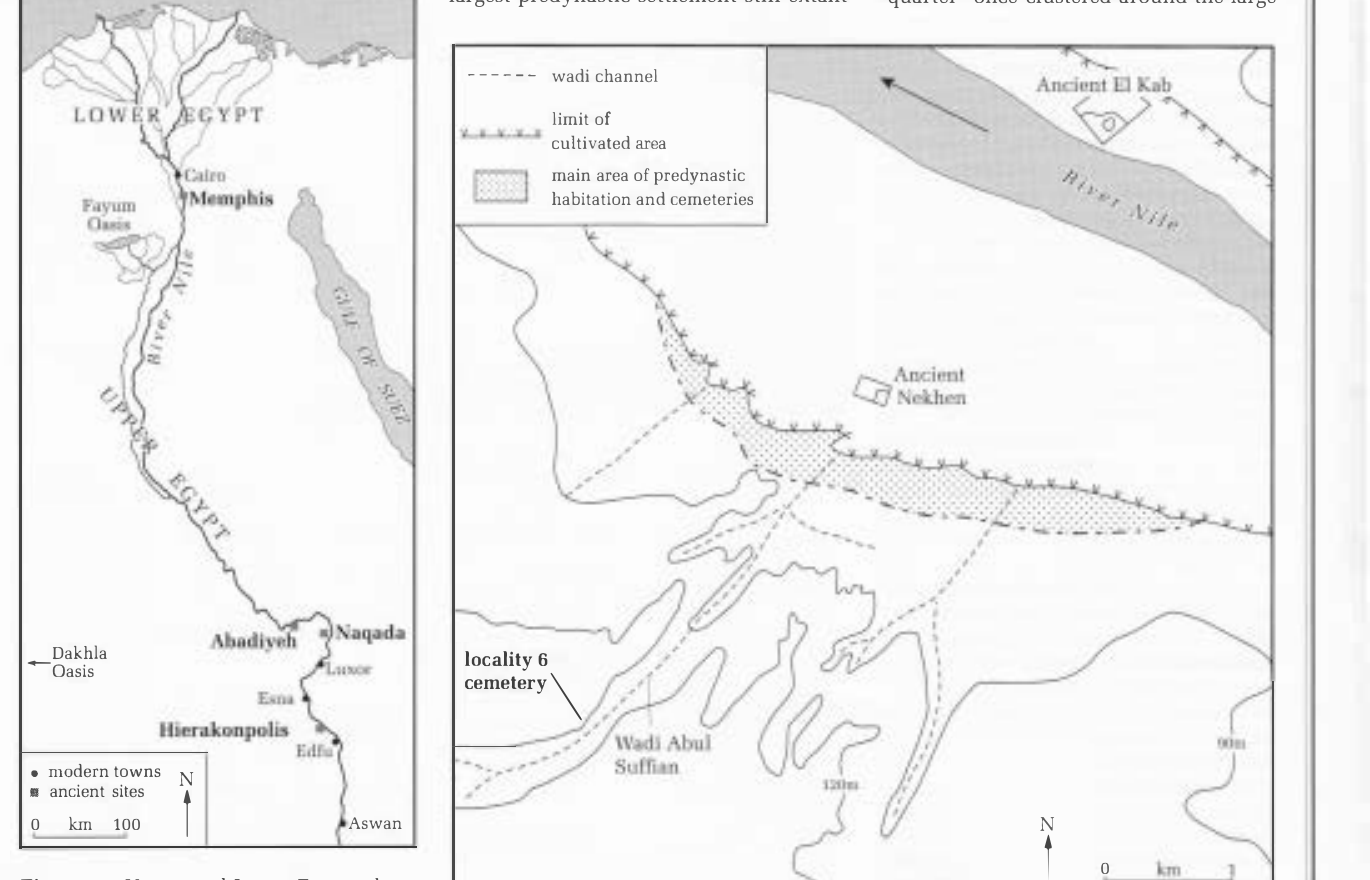
Figure 2 The predynastic settlement of Hierakonpolis and the location of the locality 6